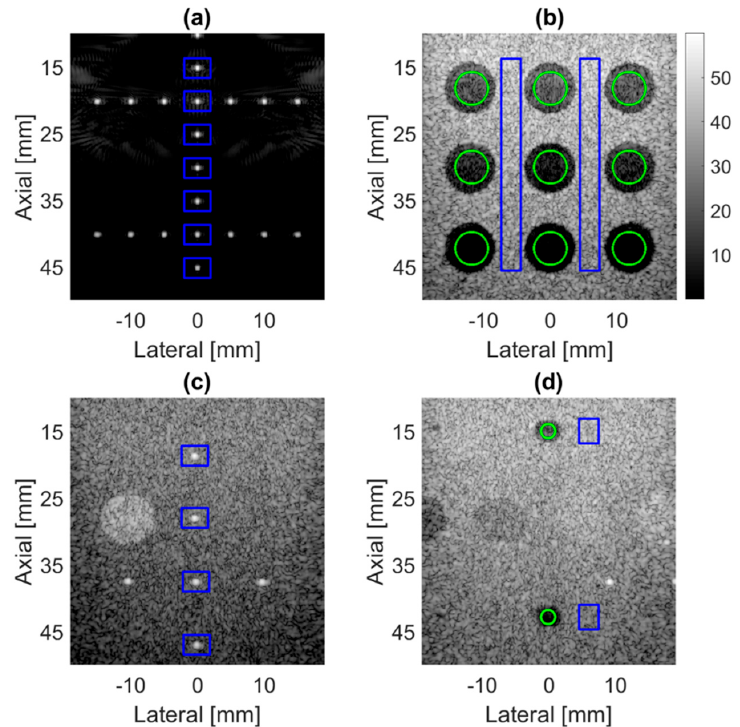
Figure 2. B-mode images of PICMUS dataset for measurement of image quality metrics. ( a , b ) Two simulation phantoms for wires and anechoic cysts in speckle background, respectively. ( c , d ) Two different field of views (FOVs) of the same experimental phantom.